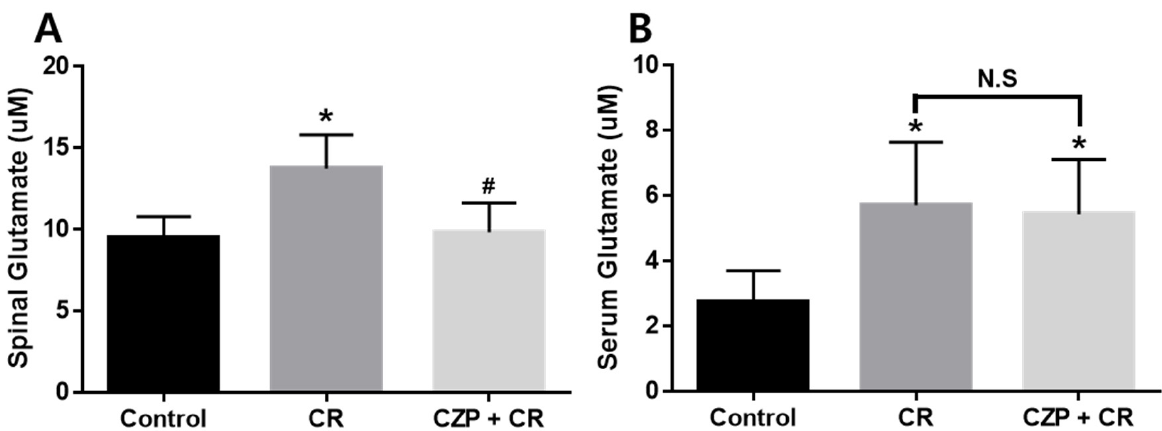
Figure 4. Graphs show the effect of intrathecal capsazepine treatment on the suppression of glutamate concentration in the spinal cord ( A ) and serum ( B ) of mice with carrageenan-induced inflammatory pain. Spinal glutamate concentration was significantly higher in carrageenan-injected animals (CR, n = 5) than in the control group (Control, n = 5, * p < 0.05). Glutamate concentration in the spinal cord was significantly lower in intrathecal capsazepine-treated animals (CZP + CR, n = 5) than in the carrageenan-injected group (# p < 0.05). Serum glutamate concentration was significantly higher in carrageenan-injected mice (CR, n = 5) and capsazepine-administered mice (CZP + CR, n = 5) than in control mice (Control, * p < 0.05). No significant differences (N.S) were observed in glutamate concentration between intrathecal capsazepine- treated mice and the carrageenan-treated